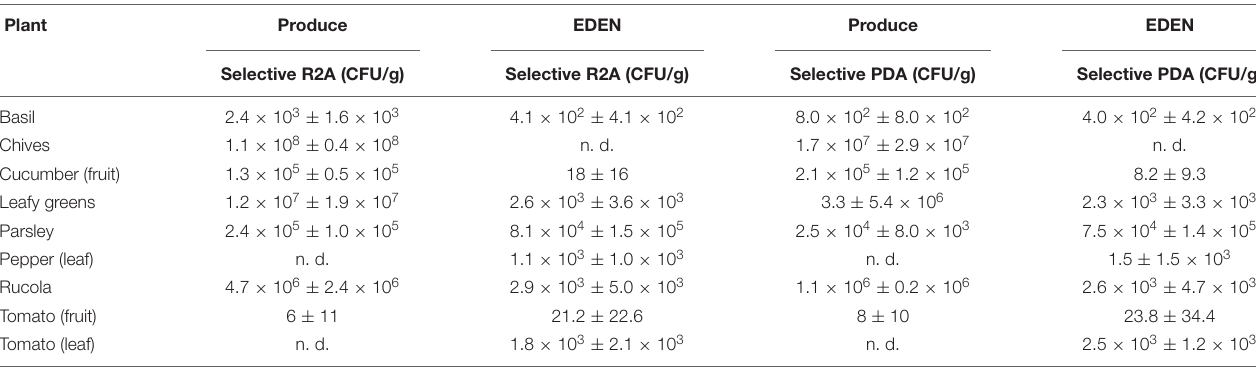
TABLE 1 | Overview of cultivable organisms on produce and on EDEN plants.